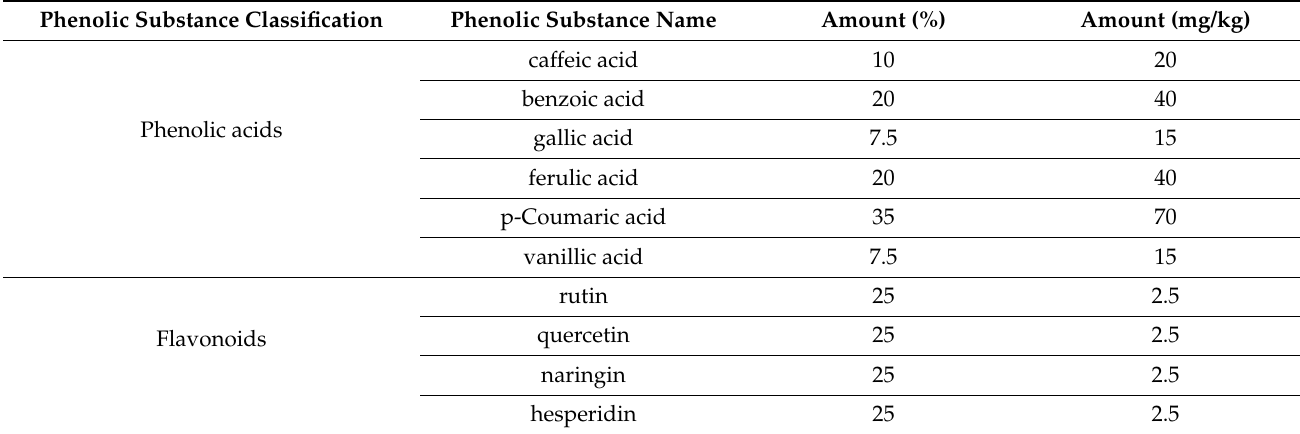
Table 1. Content of phenolic acids and flavonoids used in the phenolic mixture. Phenolic Substance